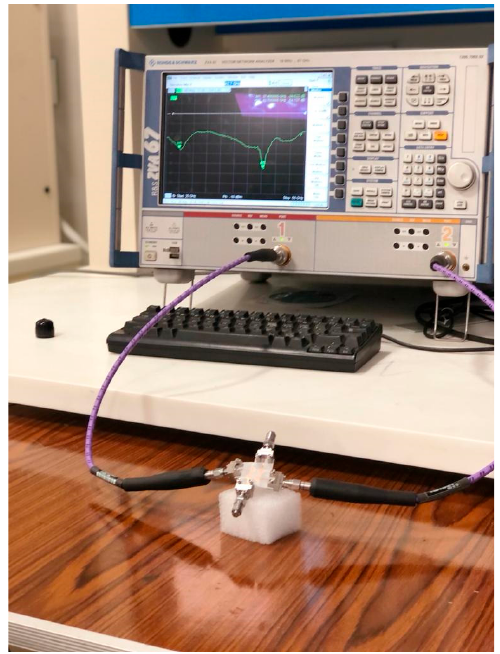
Figure 3. Measurement setup of proposed MIMO using ROHDE & SCHWARZ ZVA67 Vector Network Analyzer.